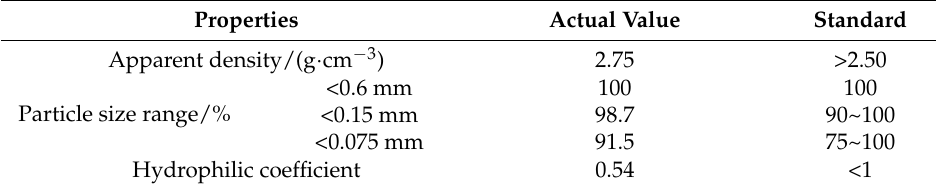
Table 4. Properties of mineral filler.